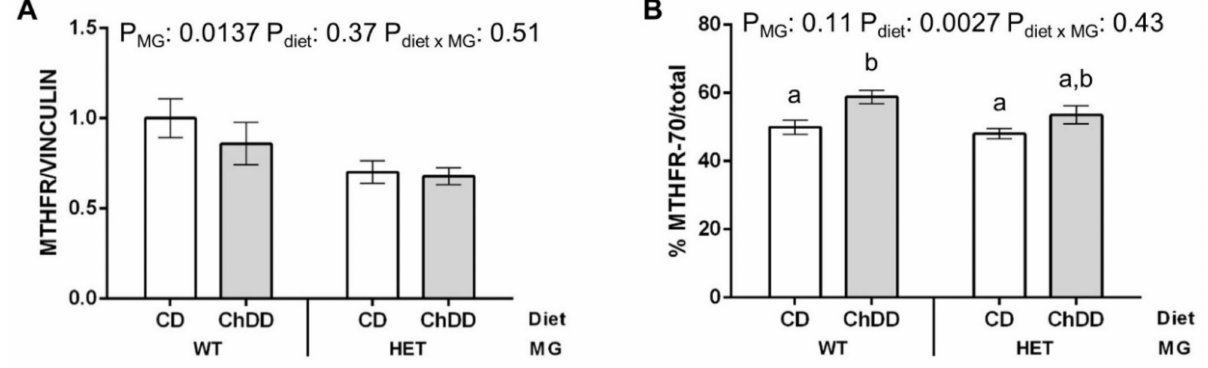
Figure 5. Effect of synthetase deficiency and low choline diet on maternal liver MTHFR expression. A representative blot is shown in Figure S6. ( A ) Total MTHFR expression, normalized to vinculin. ( B ) Expression of the more active 70 kDa isoform of MTHFR, as a percentage of total MTHFR. Values are means ± SEM, n = 6 per group. Analysed by 2-way ANOVA; means without a common letter differ significantly by Tukey post hoc ( p < 0.05). White bars: CD, grey bars: